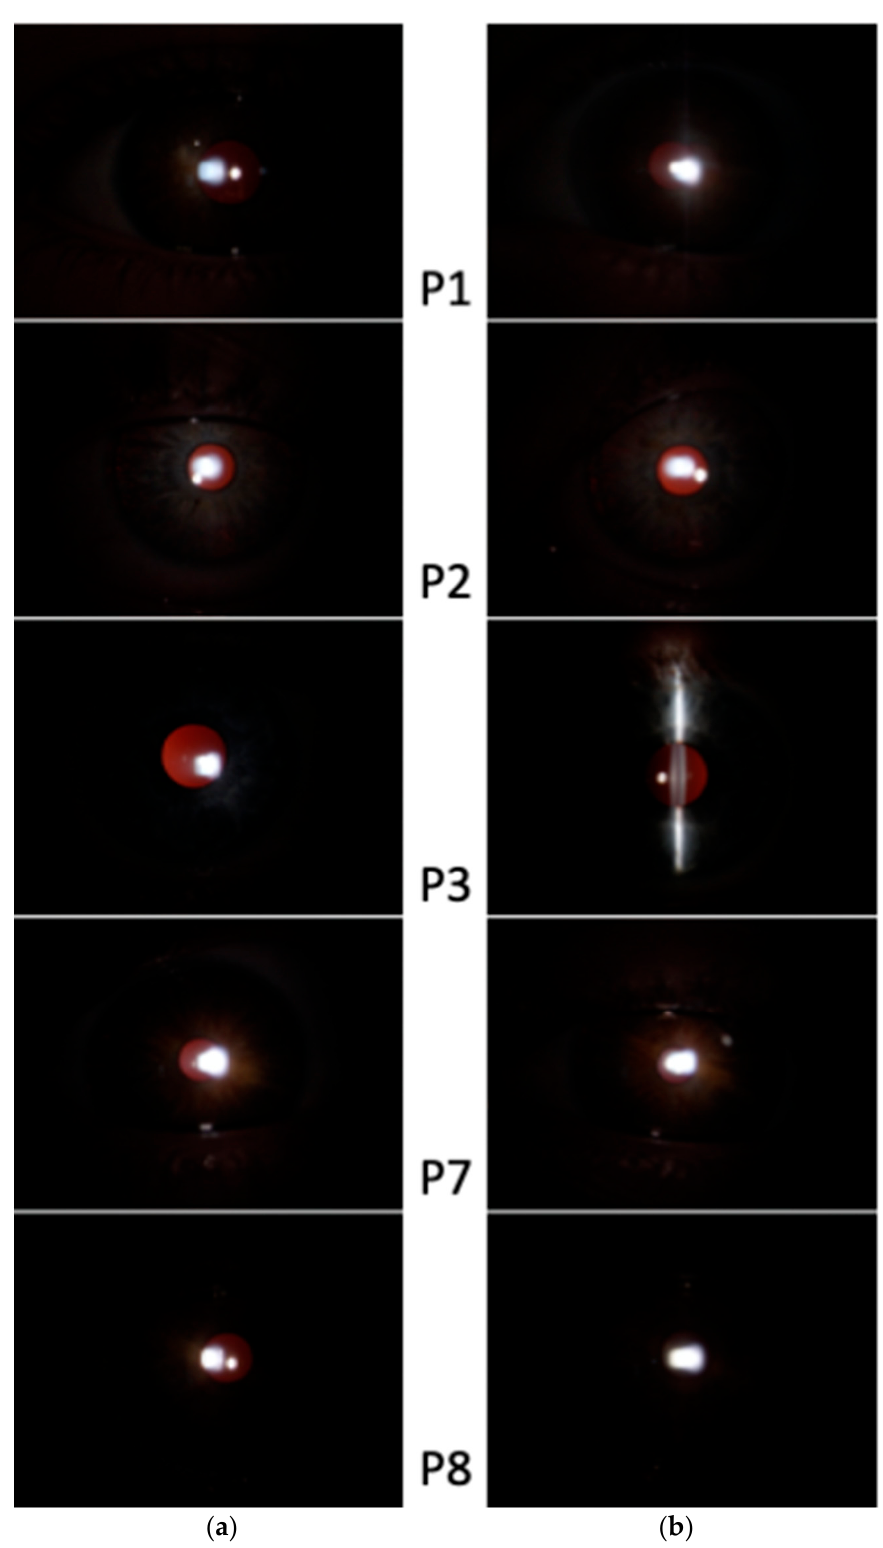
Figure 2. Slit-lamp examination: note the absence of iris translucency on retro-illumination. ( a ) Right eye. ( b ) Left eye; (images acquired with 10× magnification).